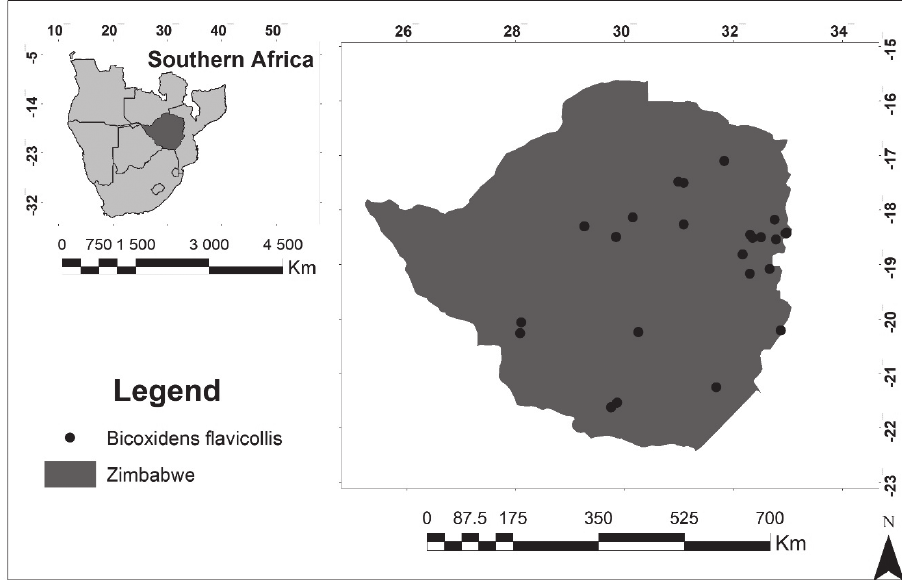
Figure 1. Distribution map of B. flavicollis in Zimbabwe, Southern